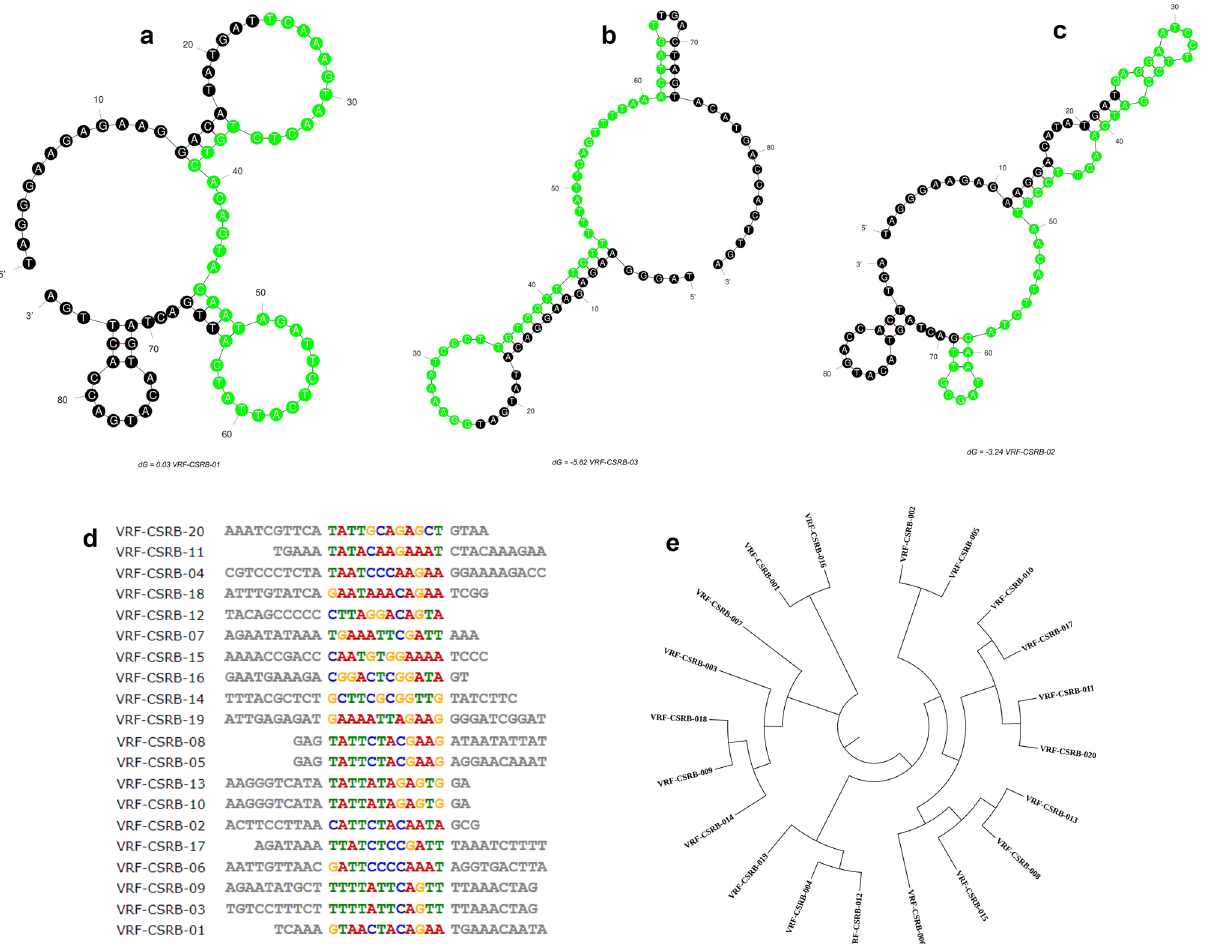
Figure 2. Secondary structure, sequence homology and phylogenetic tree. ( a – c ) Predicted secondary structures for three aptamer candidates, VRF-CSRB-01, VRF-CSRB-02 and VRF-CSRB-03 selected for further. The presented predicted secondary structures were the ones with lowest ΔG. Constant sequence regions are highlighted in black, and green represents the random regions. ( d ) Sequence homology analysis by MEME online software. ( e ) Phylogenetic analysis of aptamer candidate sequences was performed using the Tree Builder function in Geneious software (Geneious version 9.1.4, https:// www. genei ous.